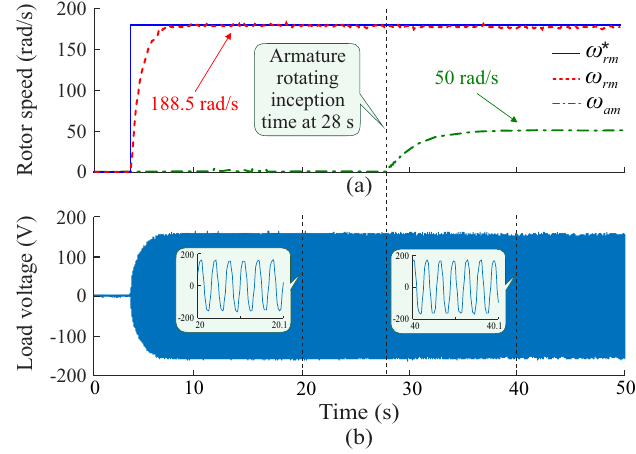
Figure 19. Experimental results for performance analysis of the EFR-based system: ( a ) rotor and armature speed and ( b ) load voltage. Table 4. Comparison between simulation and experimental results. Simulation Experimental Design Criteria Values Obtained Values Obtained Speed